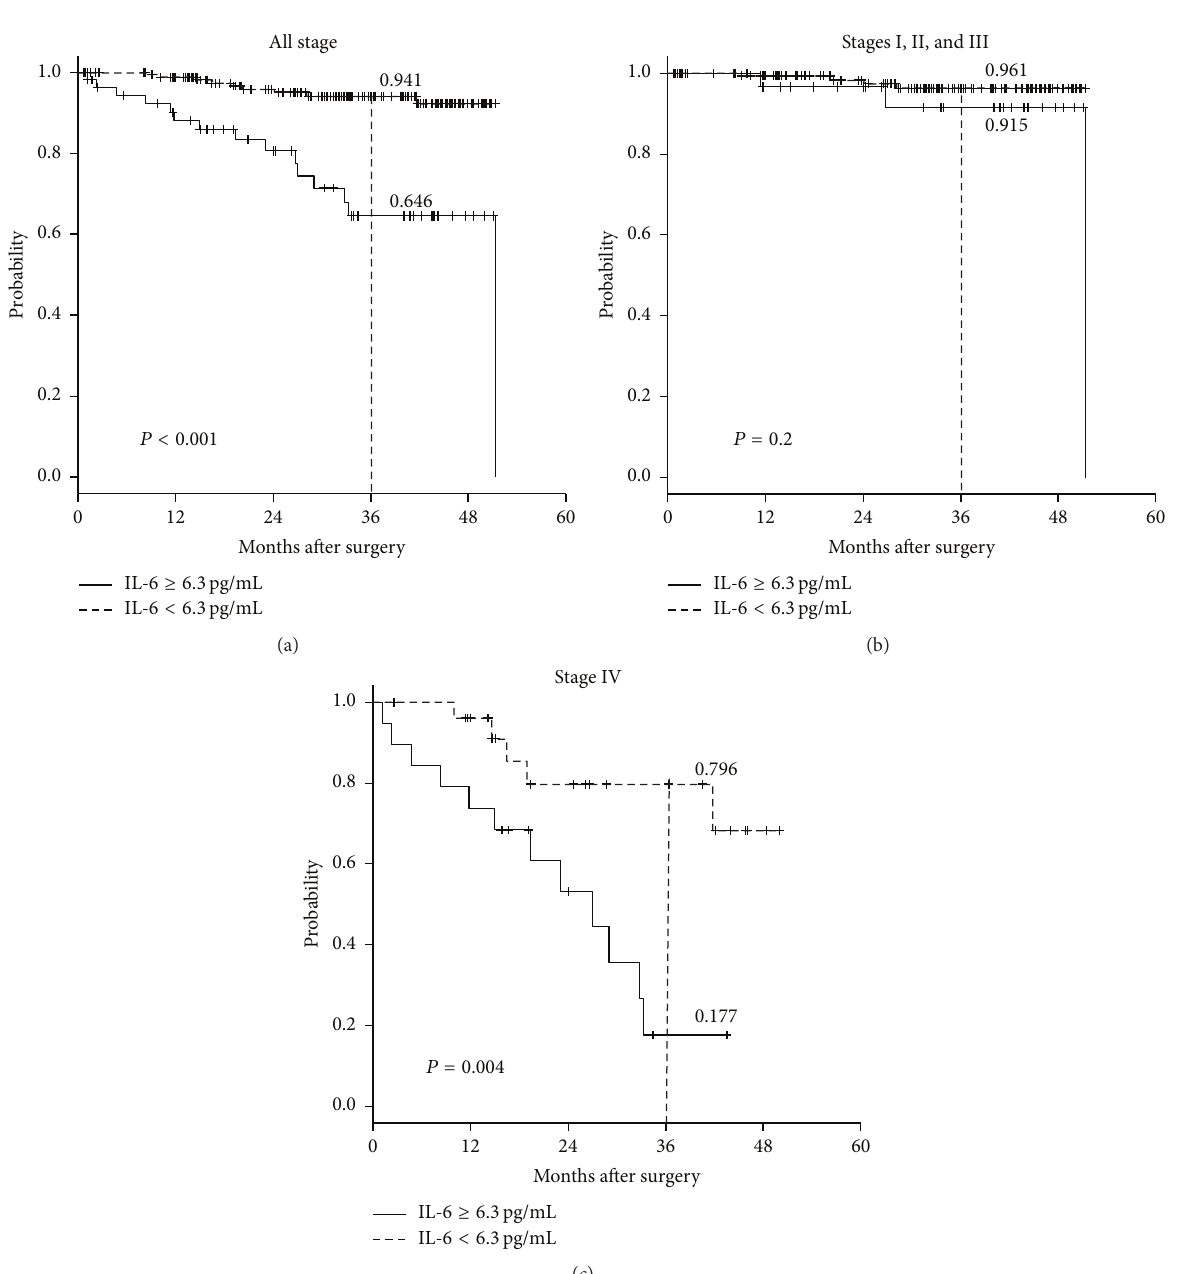
study, obstruction was not an independent prognostic factor ( 𝑃 = 0.4